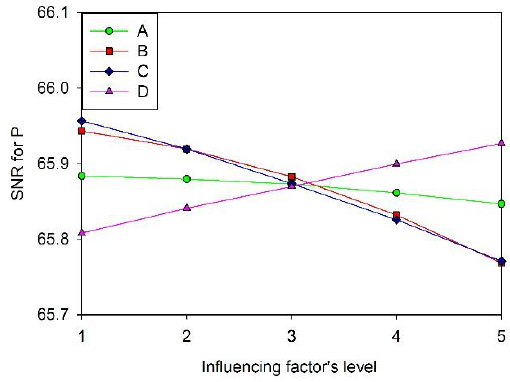
Figure 17. E ff ect diagram of SNR at di ff erent levels for P . Figure 17. Effect diagram of SNR at different levels for P. Figure 17. Effect diagram of SNR at different levels for P.